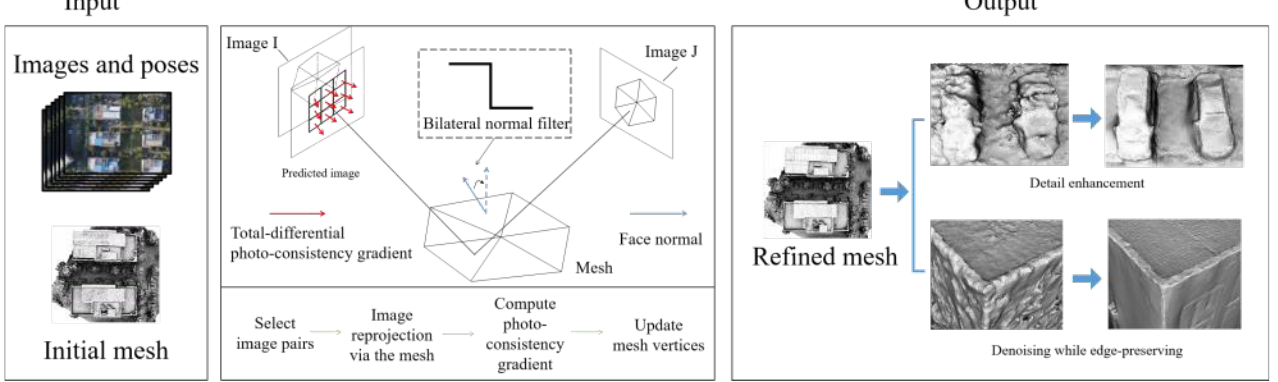
Figure 1. The flow diagram for the proposed TDR algorithm.